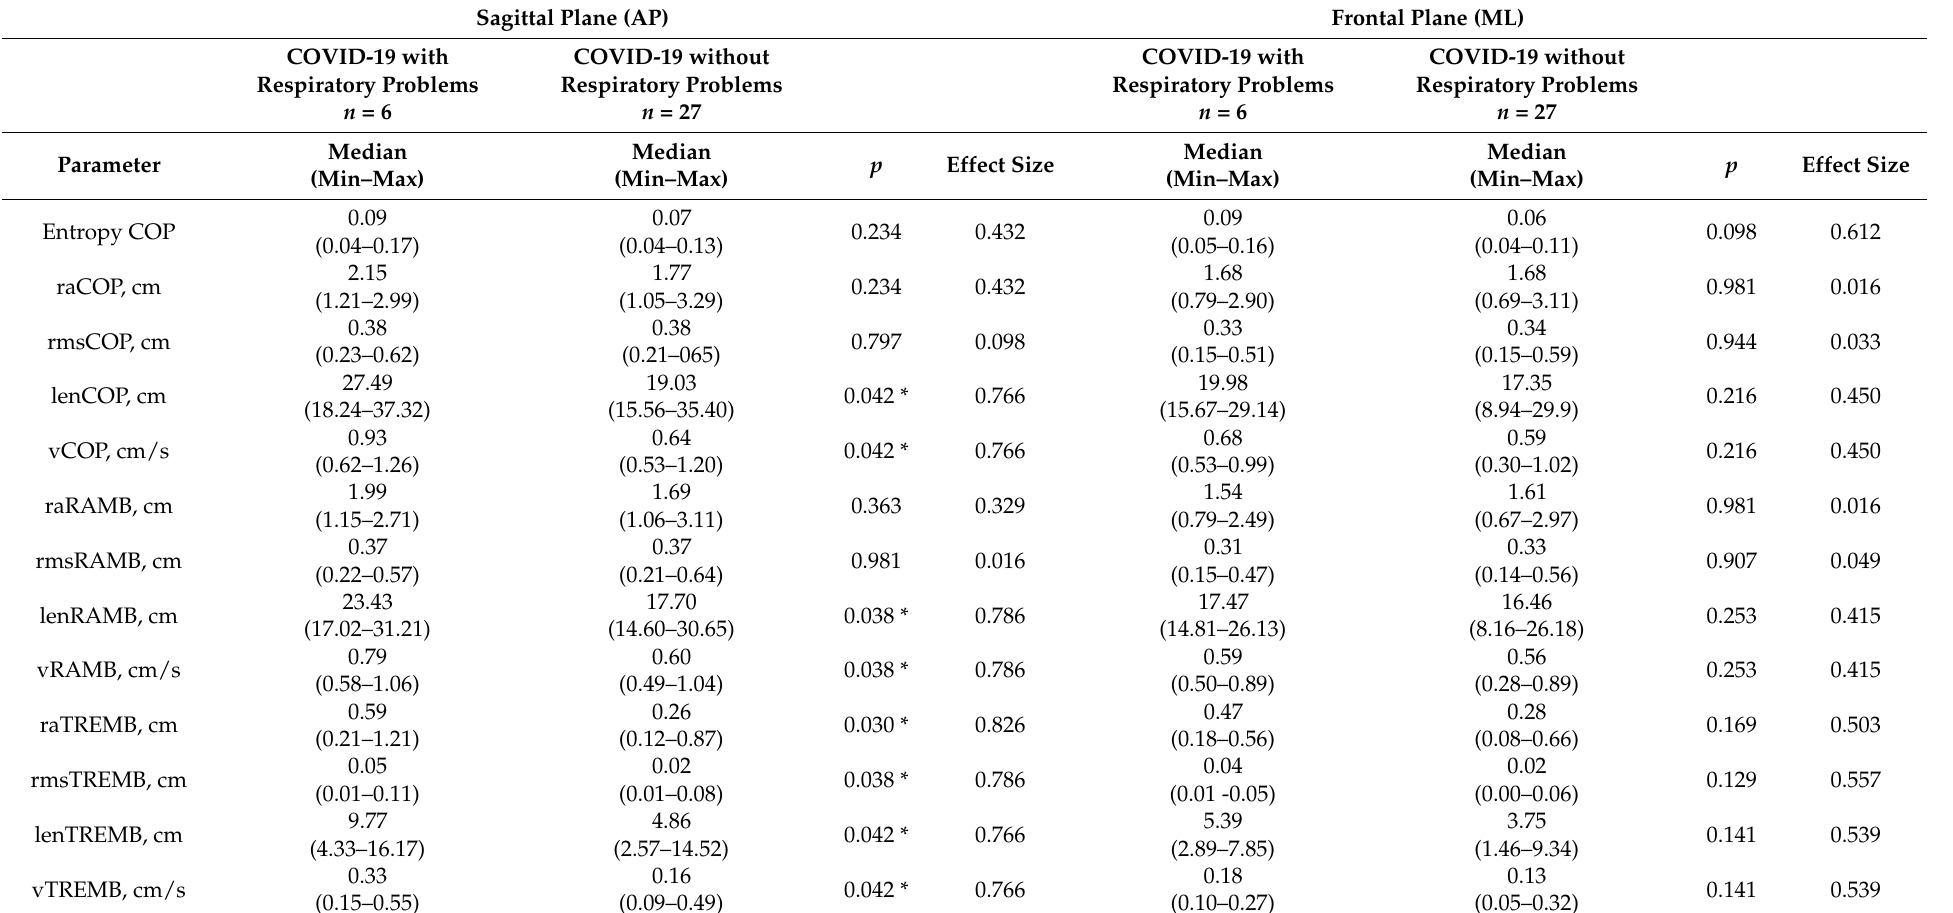
Table 2. Comparison of the stabilographic parameters (opened eyes) in subjects who reported respiratory problems ( n = 6) in the course of COVID-19 and those who did not suffer from dyspnea during the infection ( n = 27) (AP, anterio-posterior direction; ML, medio-lateral direction; COP, center of pressure; ra, range; rms, root mean square; len, length of trajectory; v, velocity; RAMB, rambling; TREMB, trembling) (* statistically